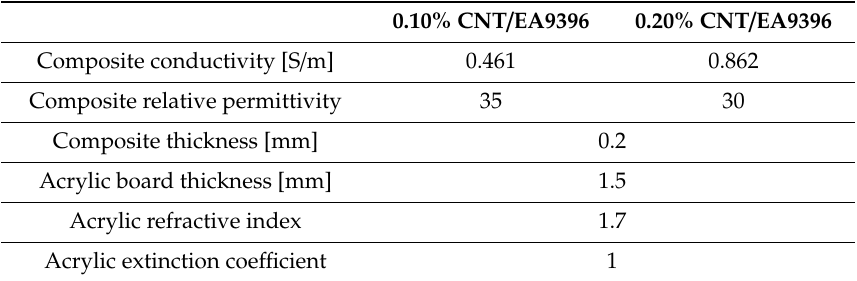
Table 1. Material properties used in the finite element model for the two composites.